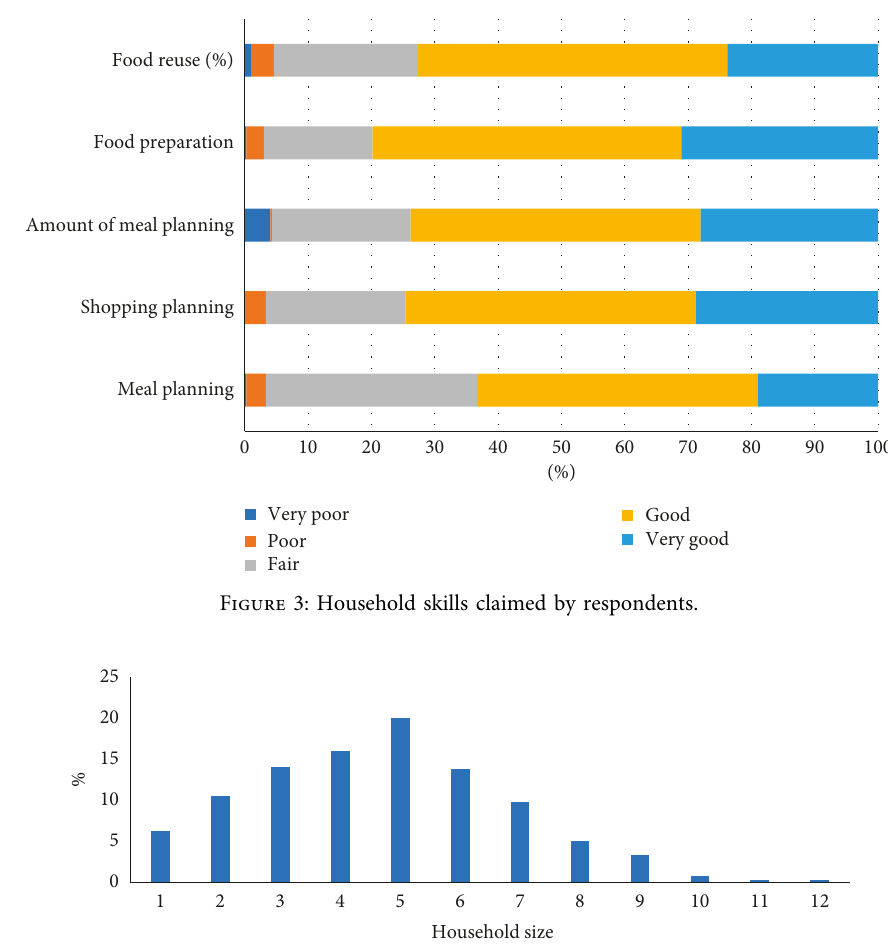
Figure 4: Household size of the Malaysians.